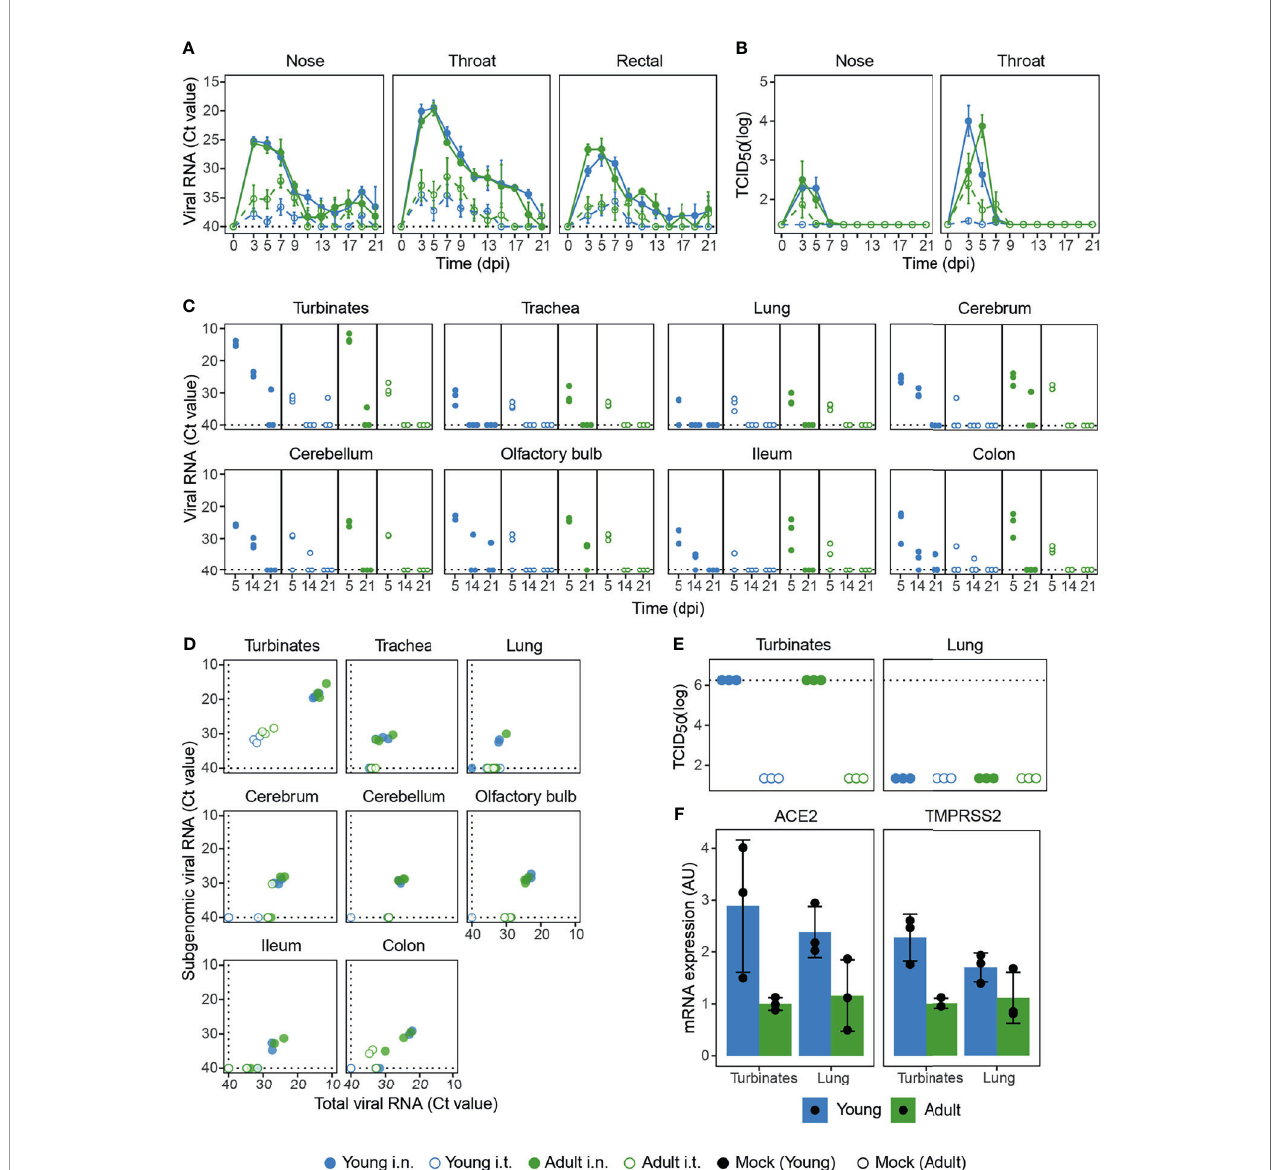
FIGURE 2 | Viral load in swabs and tissues of SARS-CoV-2 infected ferrets. (A, B) Viral load measured by RT-qPCR (A) and TCID 50 -assay (B) in swabs collected from SARS-CoV-2 infected ferrets on various days post infection (dpi). (C) Viral RNA in tissues at 5, 14 and 21 dpi measured by RT-qPCR. (D) Total viral RNA on 5 dpi as depicted in (C) plotted against subgenomic viral RNA. (E) Infectious virus detected by TCID 50 -assay in nasal turbinates and lung 5 dpi. (F) Expression of SARS-CoV-2 receptor ACE2 and TMPRSS2 protease in nasal turbinate and lung tissue of placebo animals, plotted as arbitrary units (AU). In panels (A, C, D) RT-qPCR negative specimens were set to a Ct-value of 40 for visualization purposes, which is depicted by dotted lines. In panel (E) , dotted lines depict the highest dilution tested. For (A, B) n = 3-9. For (C, F) with exception of ‘ Adult i.t. ’ on 14 dpi (n = 2), all groups are n =